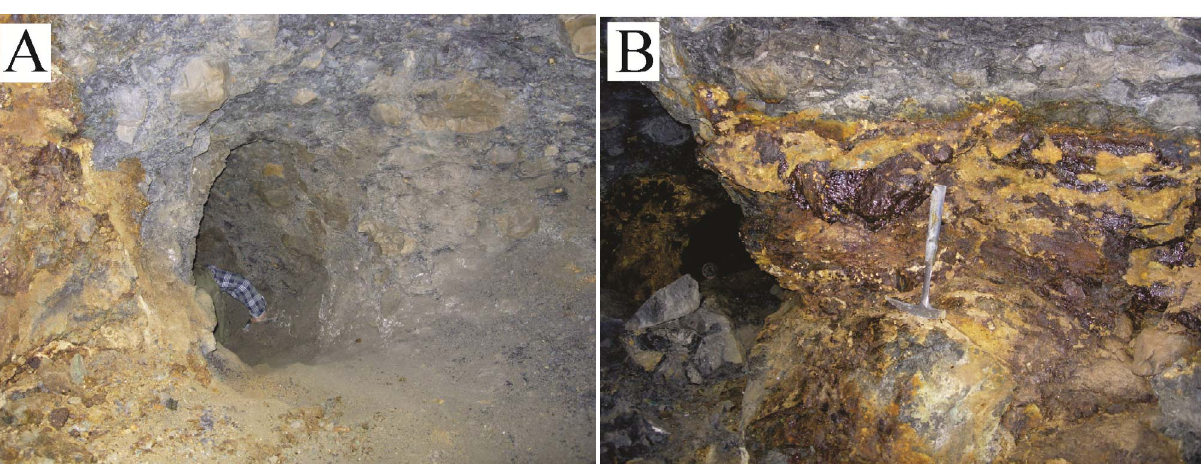
Figure 2. ( A ) and ( B ): underground view inside Cantiere Donnini mine, showing the contact between the mineralized lens and the marine